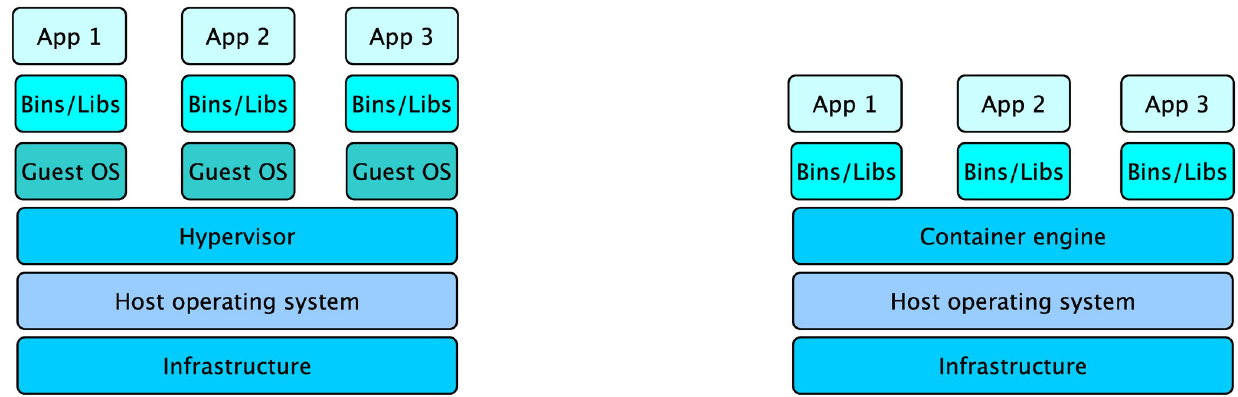
Fig 1. Comparison of hypervisor-based and container-based virtualization. Schematic illustration of hypervisor- and container-based virtualization. The container technology concept with the container engine on top of the host operating system is shown on the right side, whereas the hypervisor technology is illustrated on the left